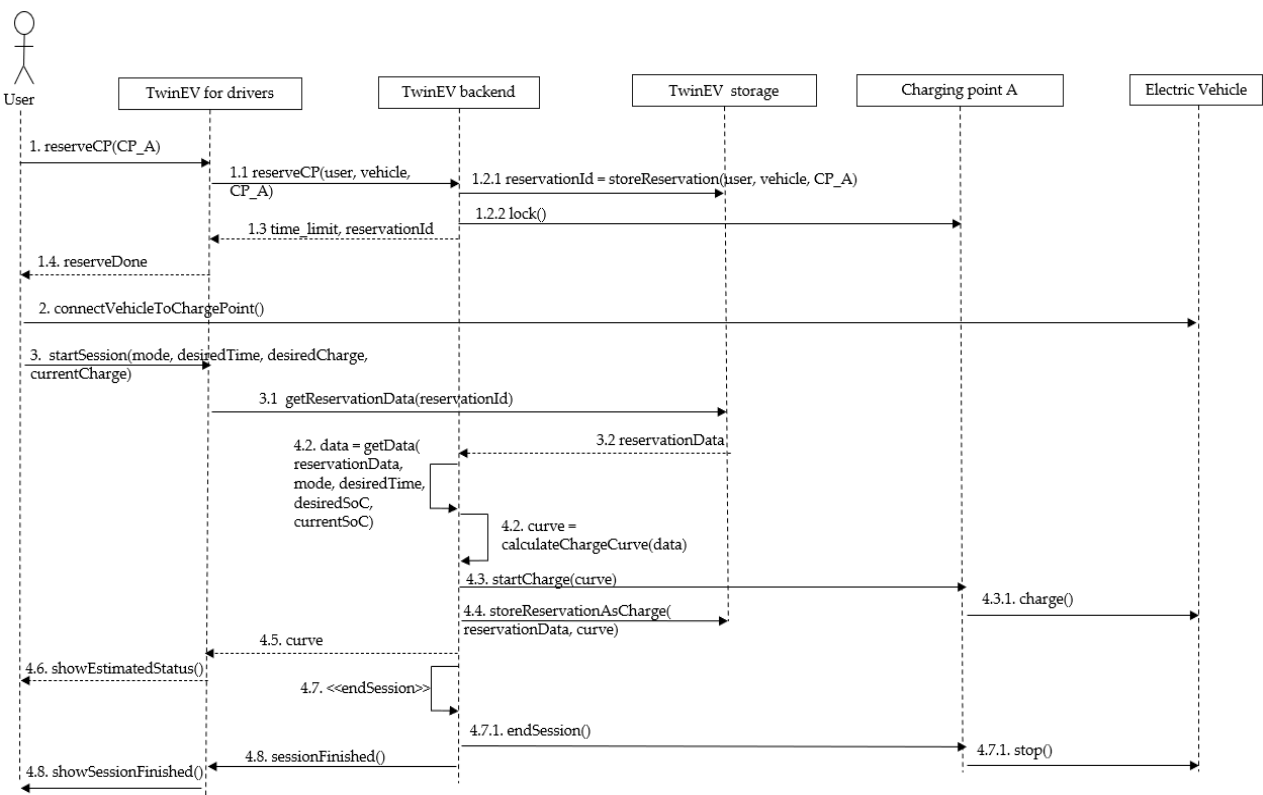
Figure 9. Actions flow for a charge session from a reservation.